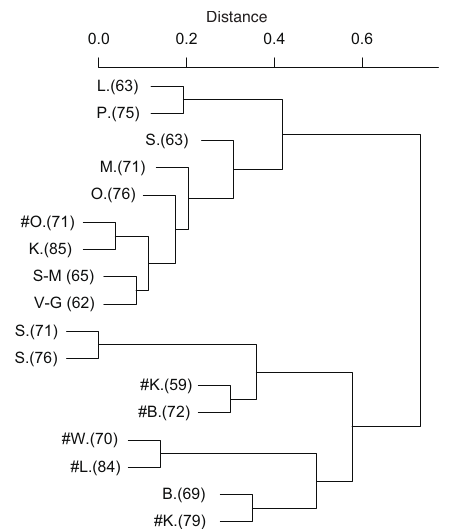
Figure 7. Dendrogram of participants using features of b100 condition; mark # are patients